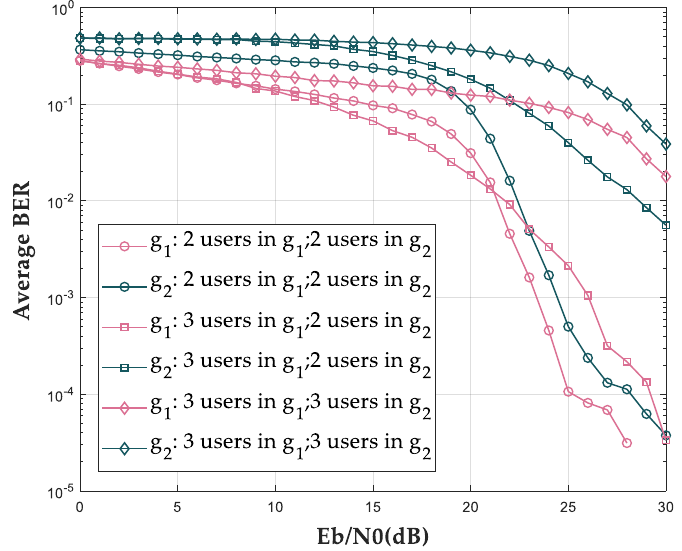
Figure 15. Average BER of two groups with different numbers of users.